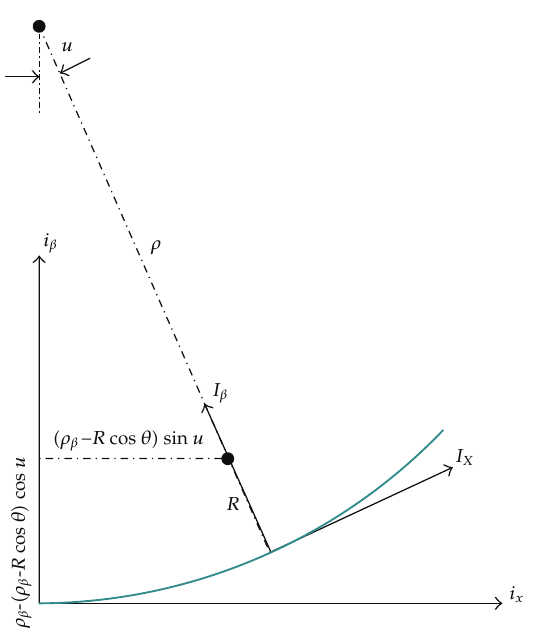
Figure 6: Torus parametric